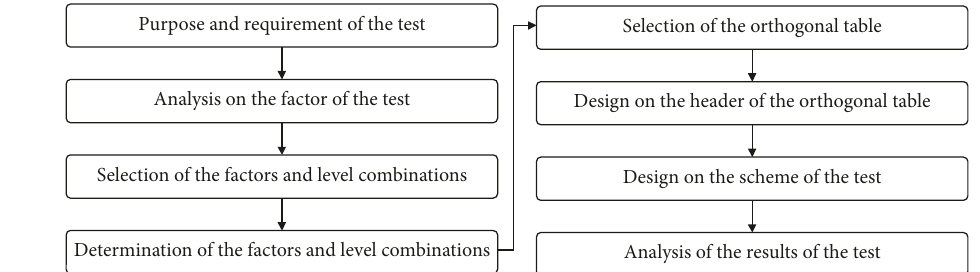
Figure 1: Basic design procedure of the orthogonal Table 1: Orthogonal table L